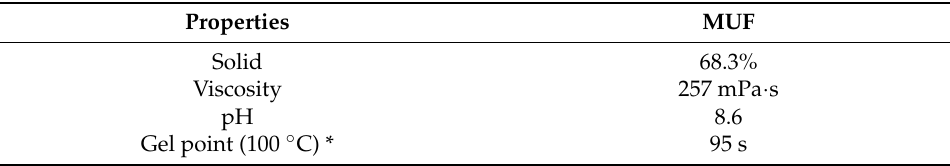
Table 3. Properties of the